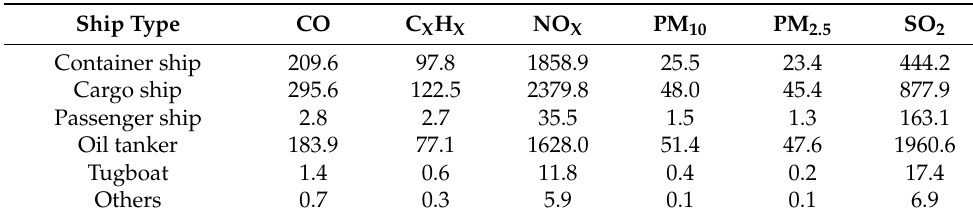
Table 11. Pollutant emissions by ship types in the Port of Long Beach (unit: ton).